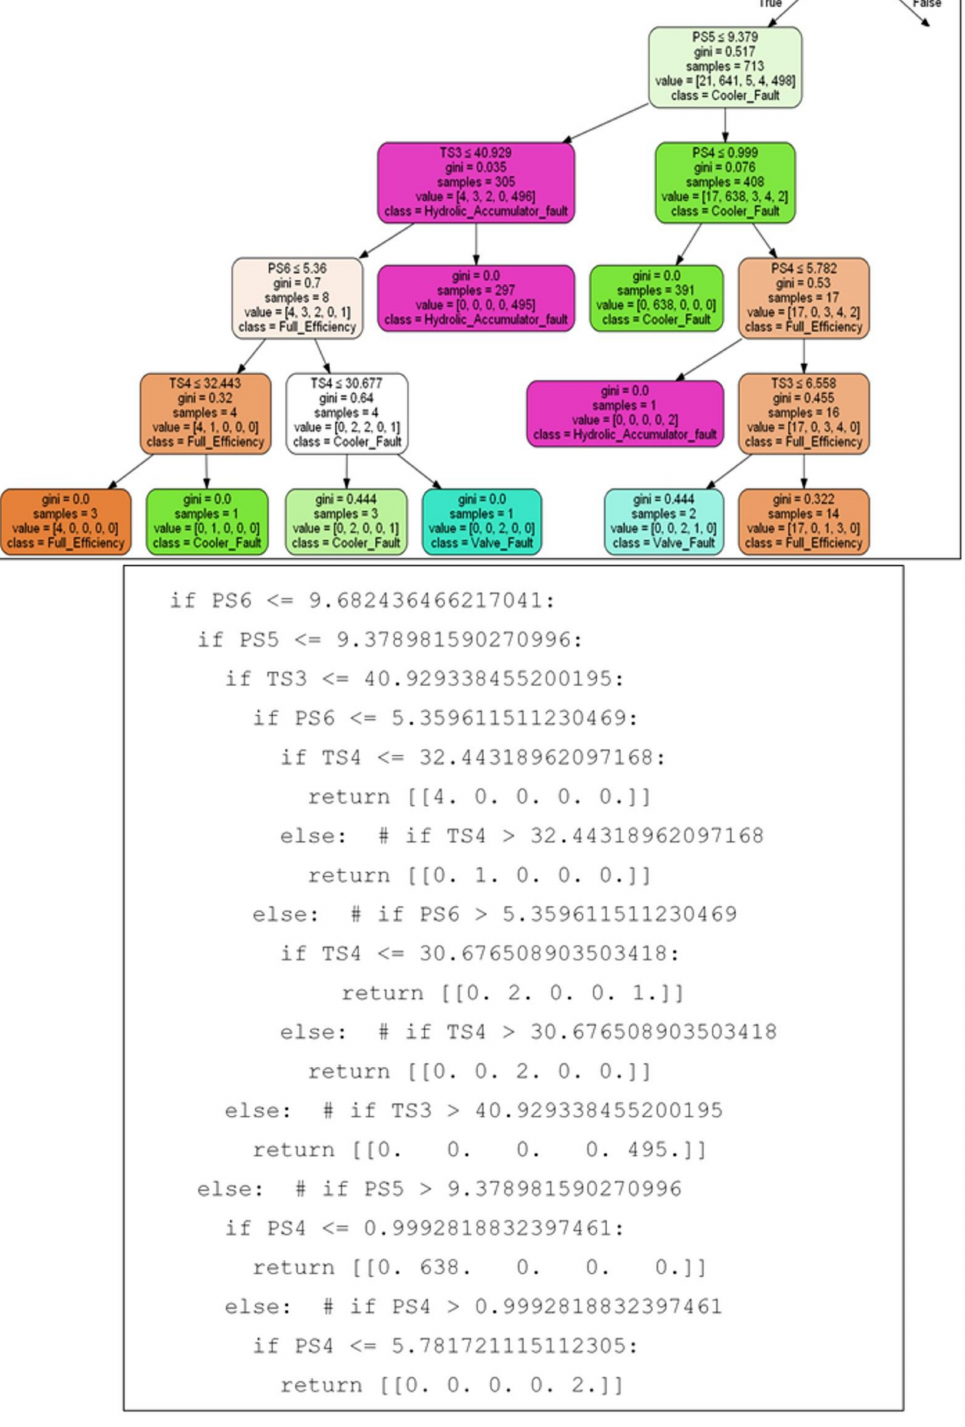
Figure 4. Diagnostic Rules Extraction from Parts of A Tree in The